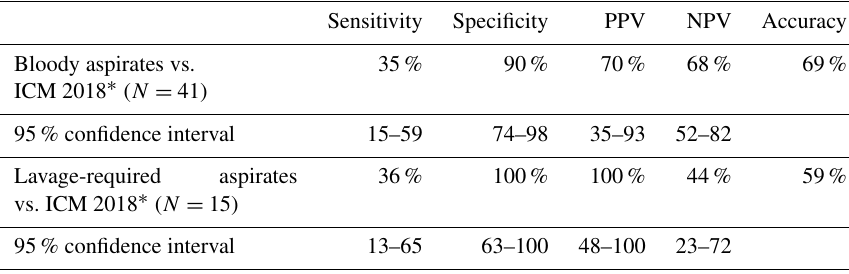
Table 6. accuracy, sensitivity, specificity, PPV, and NPV of aspiration results to ICM 2018